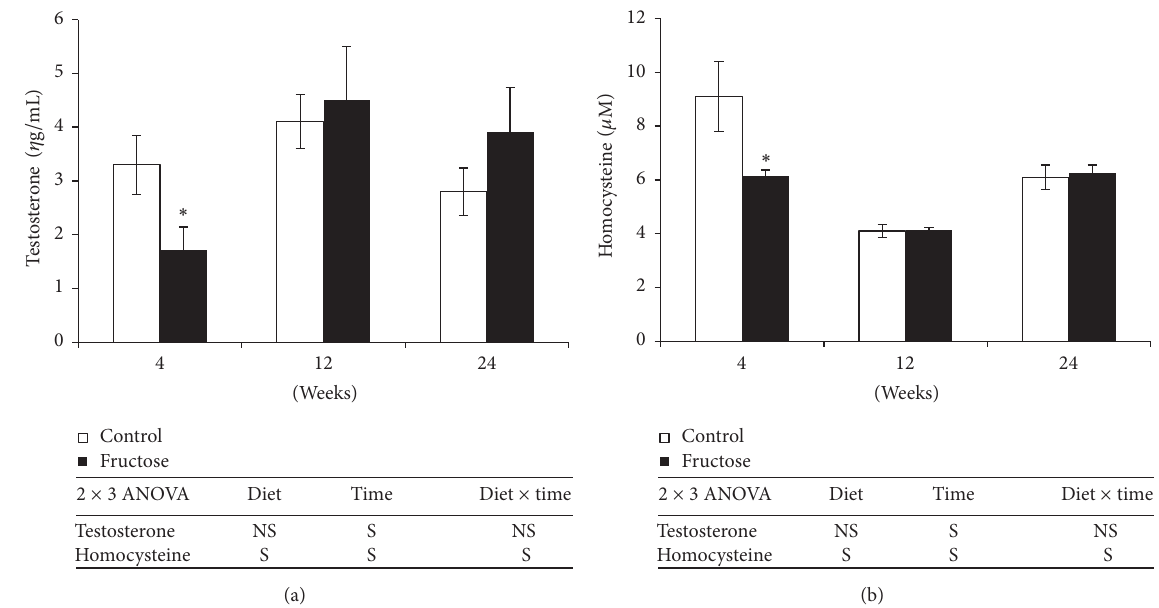
Figure 4: (a) Plasma total testosterone levels. (b) Homocysteine levels after 4, 12, and 24 weeks of control and fructose diets feeding in Sprague Dawley rats. Values are in mean ± SE. ∗ Significance at 𝑝 ≤ 0.05 by Student’s 𝑡 -test. Statistical significance of diet, time, and diet ∗ time on individual parameters is also analyzed by two-way ANOVA. “S” indicates “significant” ( 𝑝 ≤ 0.05 ); “NS” indicates “not